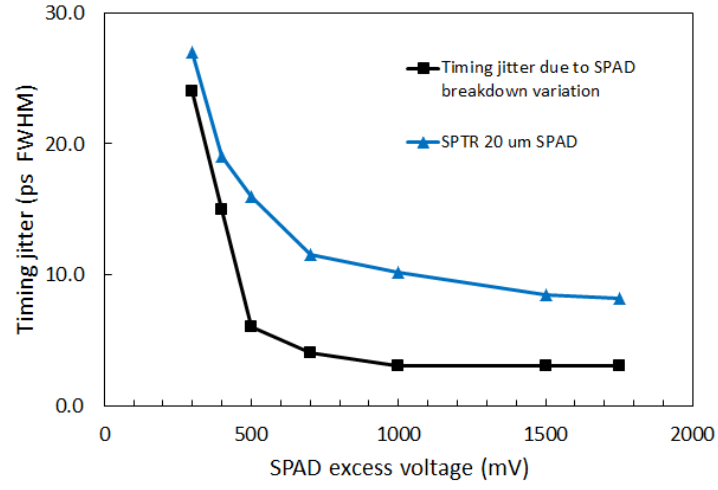
Figure 17. Timing jitter contribution of the SPAD excess voltage variation compared to the measured SPAD and QC